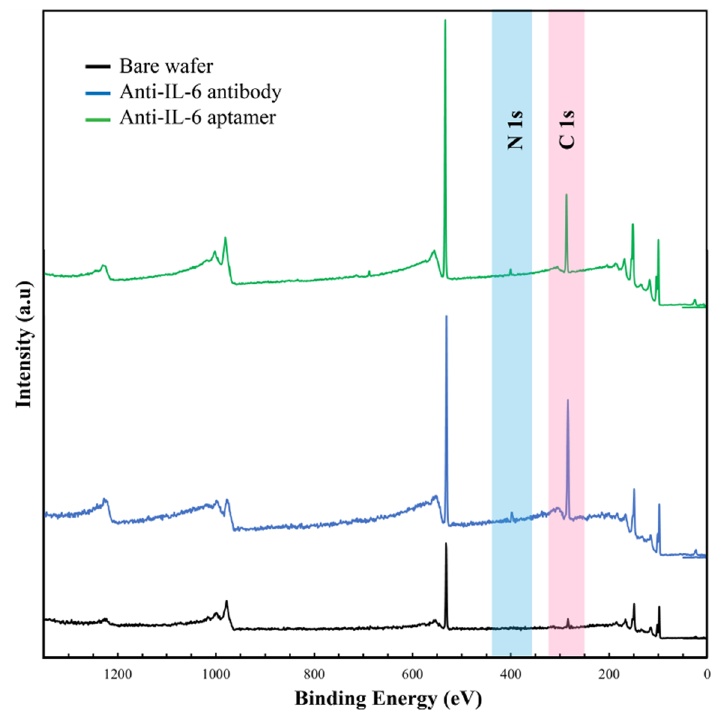
Figure 3. The XPS survey spectra of the bare wafer (in black), wafer surface with immobilized anti-IL-6 antibody (in blue), and wafer surface with immobilized anti-IL-6 aptamer (in green).